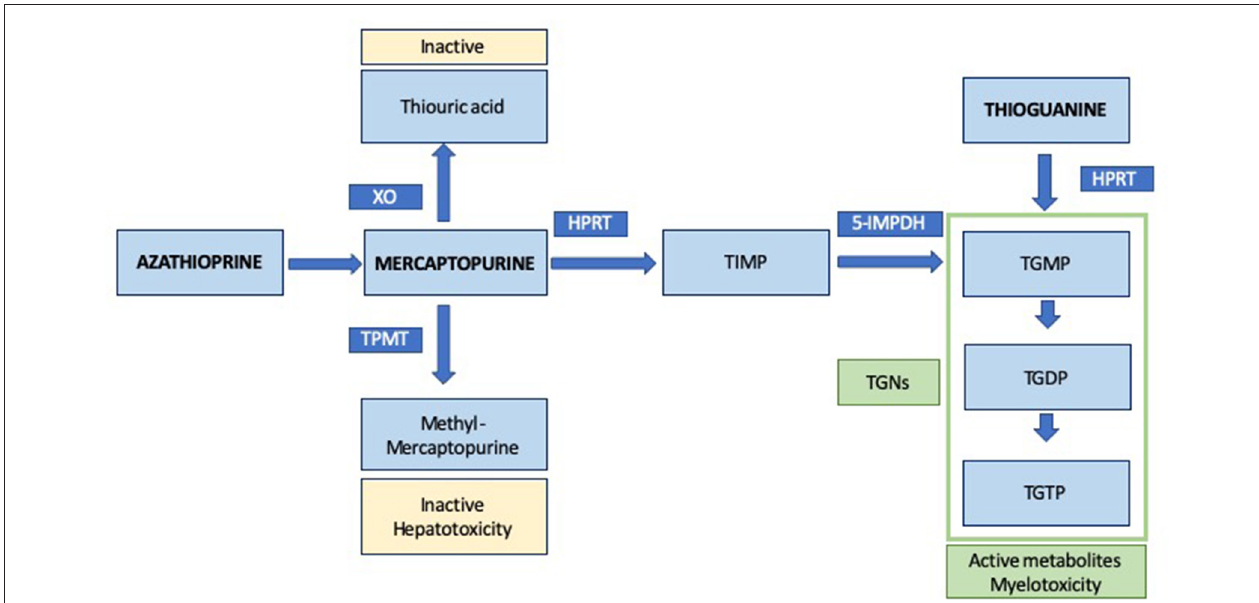
FIGURE 1 | Simplified metabolism of thiopurines. XO, xanthine oxidase; TPMT, thiopurine methyltransferase; HPRT, hypoxanthine-guanine phosphoribosyltransferase; 5-IMPDH, 5- inosine monophosphate dehydrogenase; TIMP, thiosine monophosphate; TGNs, thioguanine nucleotides; TGMP, thioguanine monophosphate; TGDP, thioguanine diphosphate; TGTP, thioguanine triphosphate.